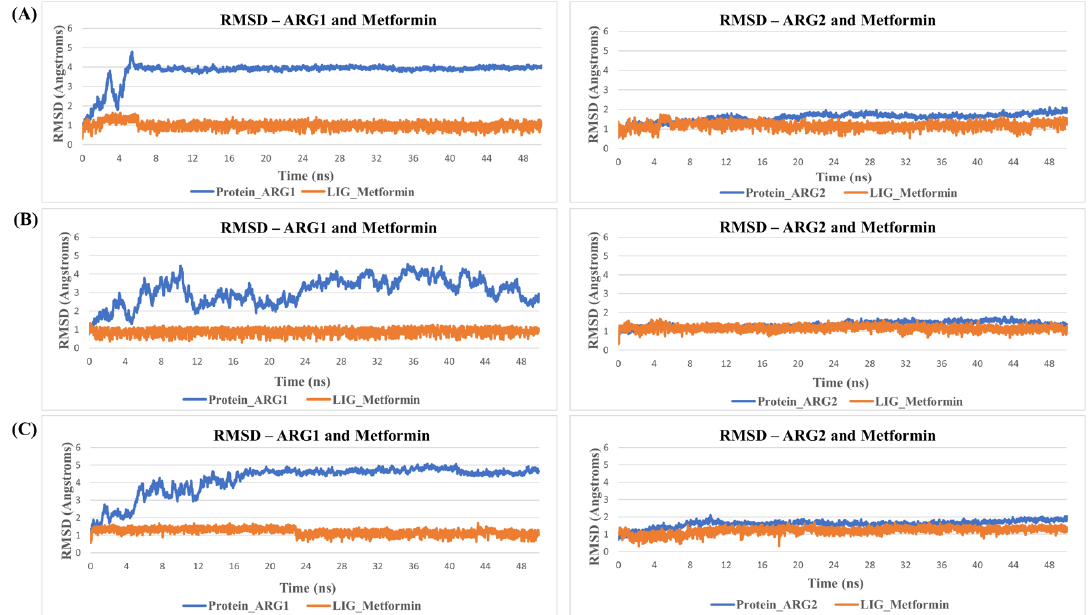
Figure 6. RMSDs during MD simulation. Shown is an example of RMSD values of Metformin in the binding site of arginase during MD simulation. Protein is represented in blue and ligand in orange. Here, ( A ) represent replicate Set A, ( B ) replicate Set B, and ( C ) replicate Set C.